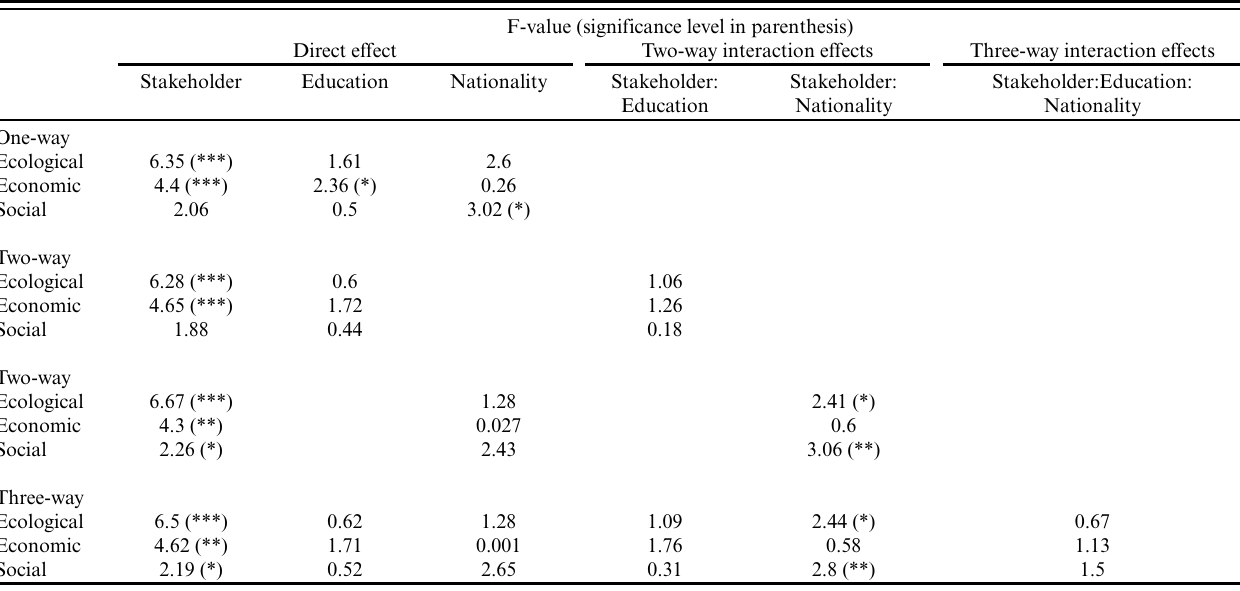
Table 1. Results from one-way (stakeholder group), two-way (stakeholder group/education), and three-way (stakeholder group/ education/nationality) ANOVA of average pillar scores.